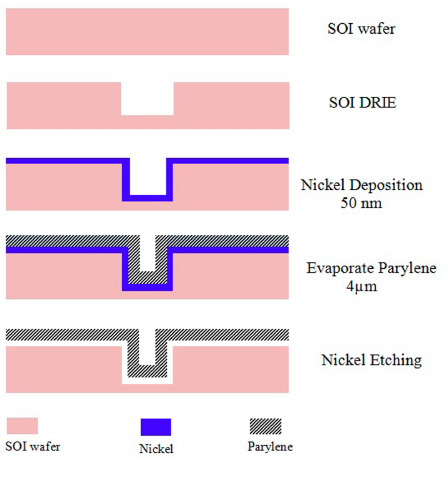
Figure 13. Process flow diagram for the lower portion of the Parylene microtube